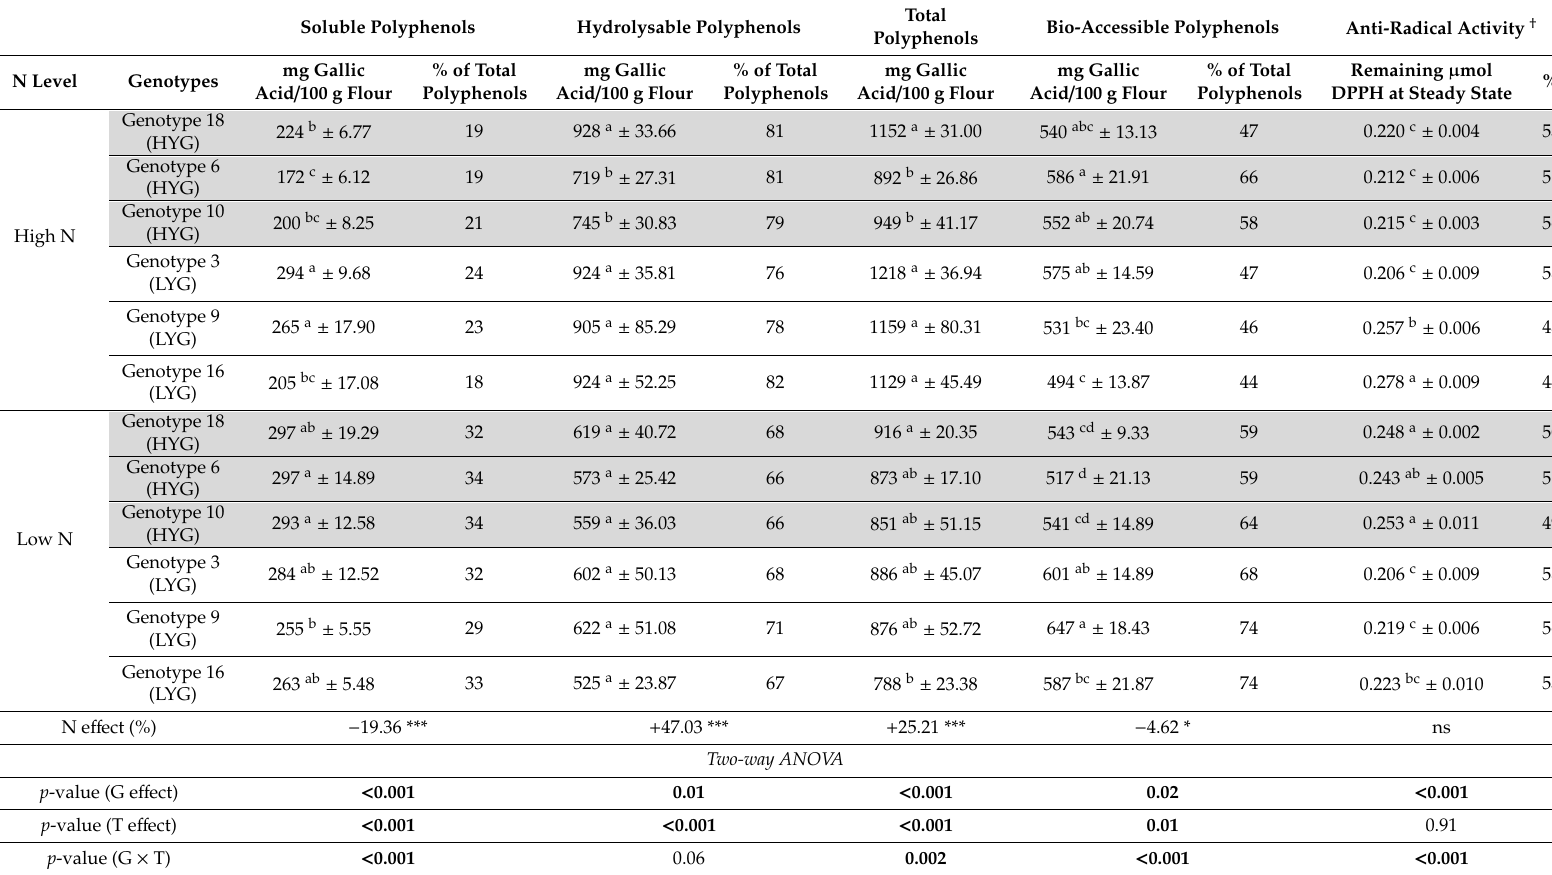
Table 5. Polyphenol fractions and anti-radical activity of 6 wheat genotypes fertilized by two nitrogen levels (High and Low). Means are followed by standard error (n =